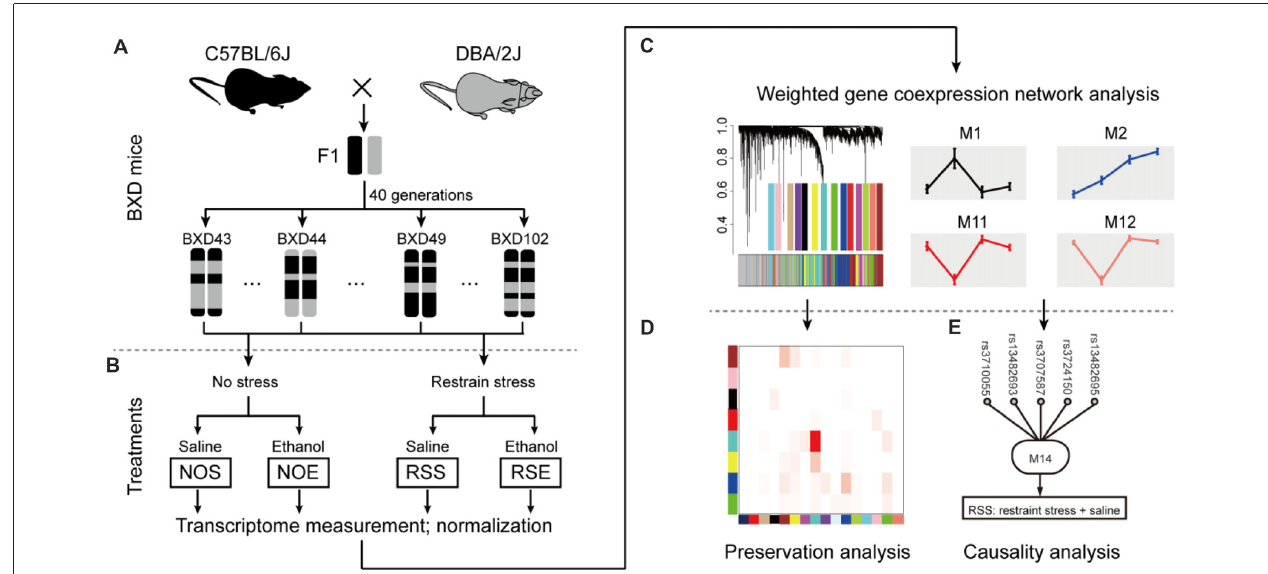
FIGURE 1 | Diagram showing network-based data analysis. (A) The expression data were generated from the BXD recombinant inbred (RI) mice. (B) The transcripts of these four conditions were compared and analyzed. (C) Weighted gene co-expression network analysis by WGCNA. (D) Conservative analysis of gene modules under experimental conditions. (E) Causal